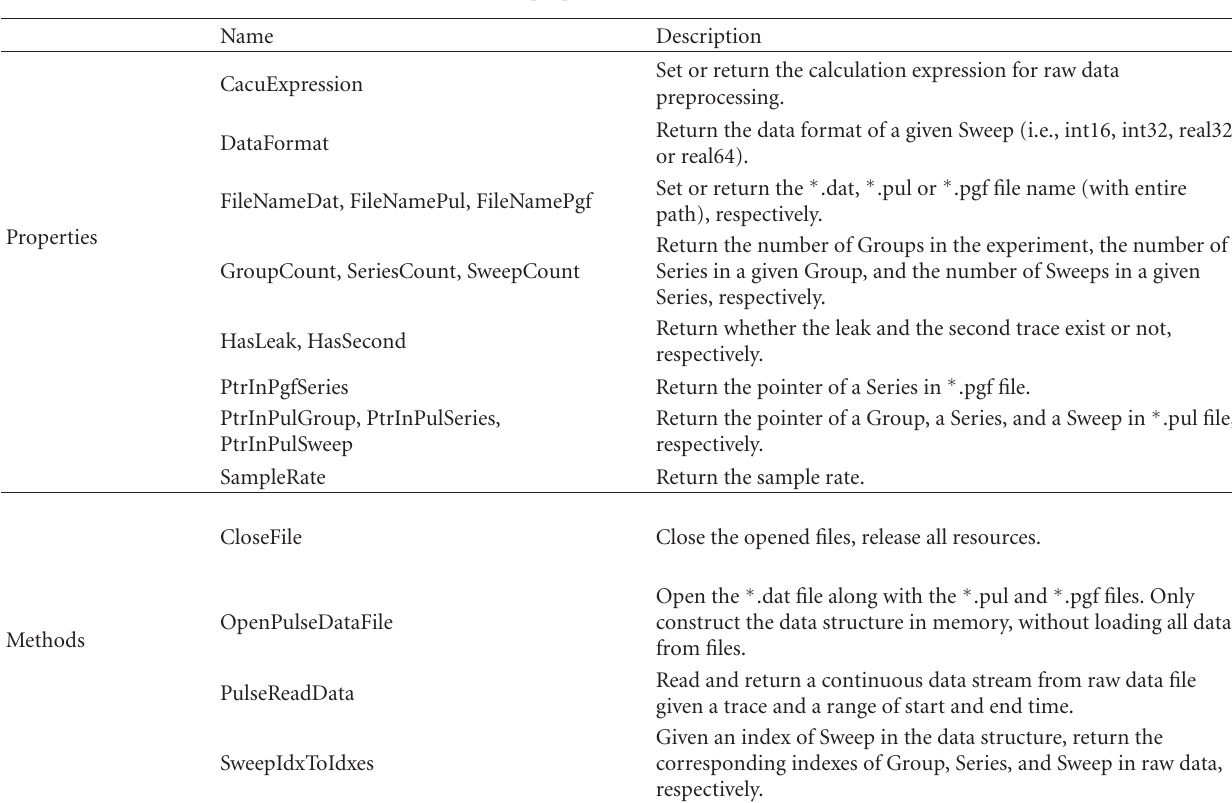
Table 2: List of some of the properties and methods of the clsPulseData